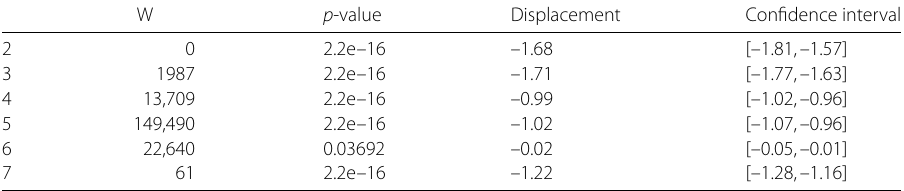
Table 9 Wilcoxon rank sum test results for differences in absolute errors between our method and the baseline. The second column indicates the Wilcoxon statistic per each level of the test W p -value Displacement Confidence interval 2